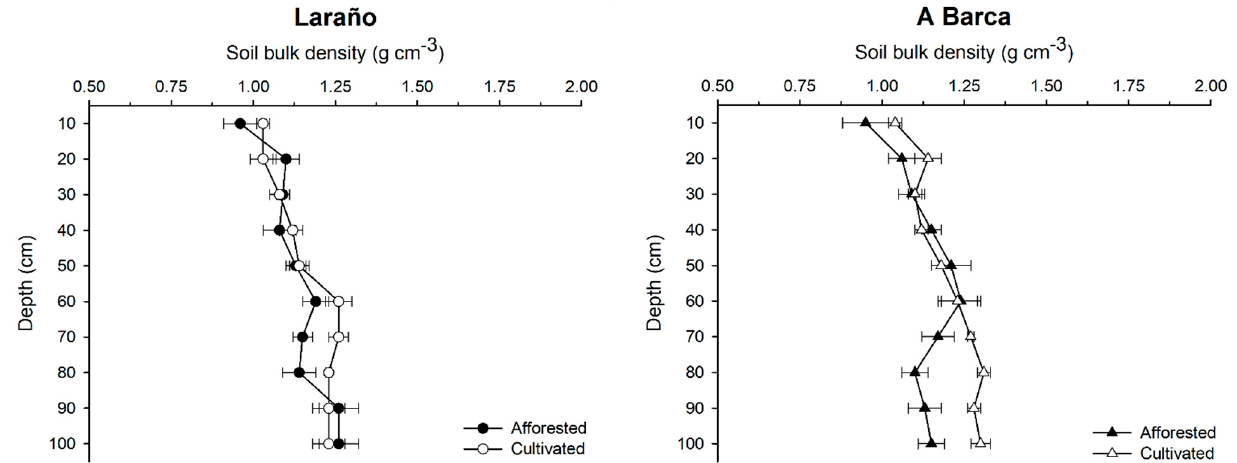
Figure 2. Bulk density values (g cm − 3 ; mean values ± standard deviation, n = 3) at different depths in the soils under study.